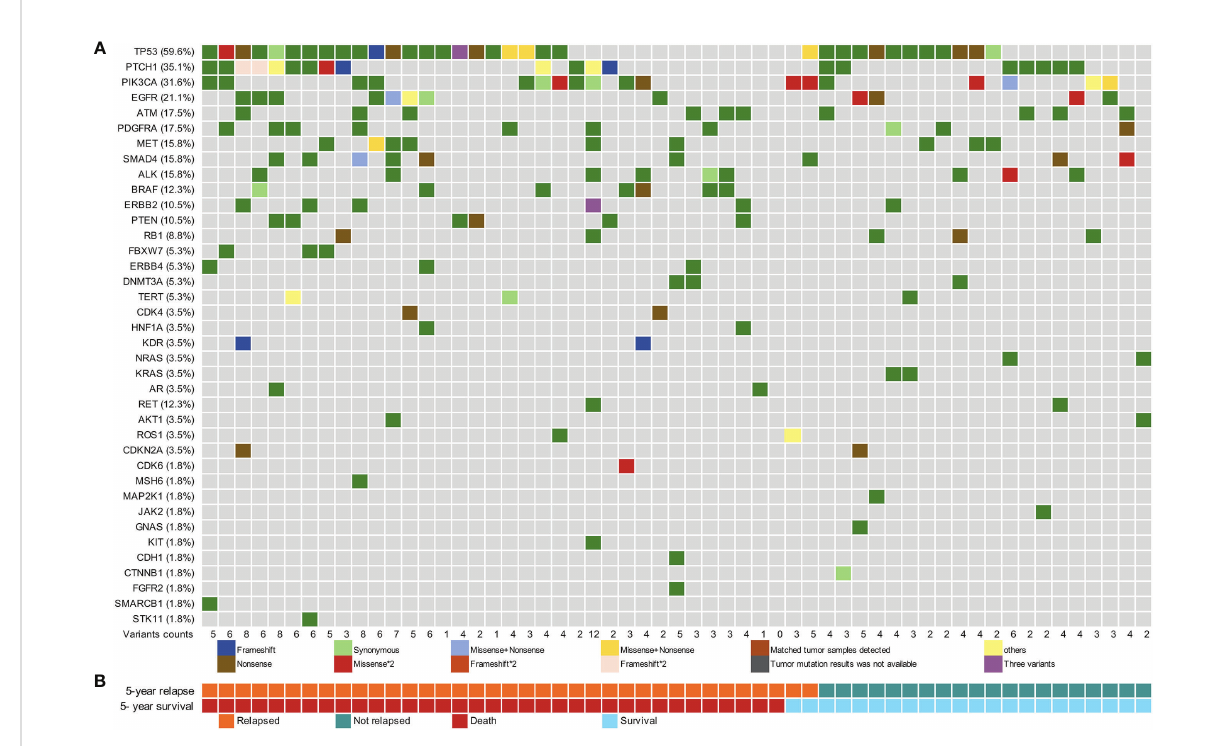
FIGURE 2 Pre-surgical circulating tumor DNA mutation signature of 57 patients with esophageal squamous cell carcinoma. (A) Pre-surgical circulating tumor DNA (ctDNA) mutational landscape of 57 patients. (B) The 5-year recurrence and survival status of